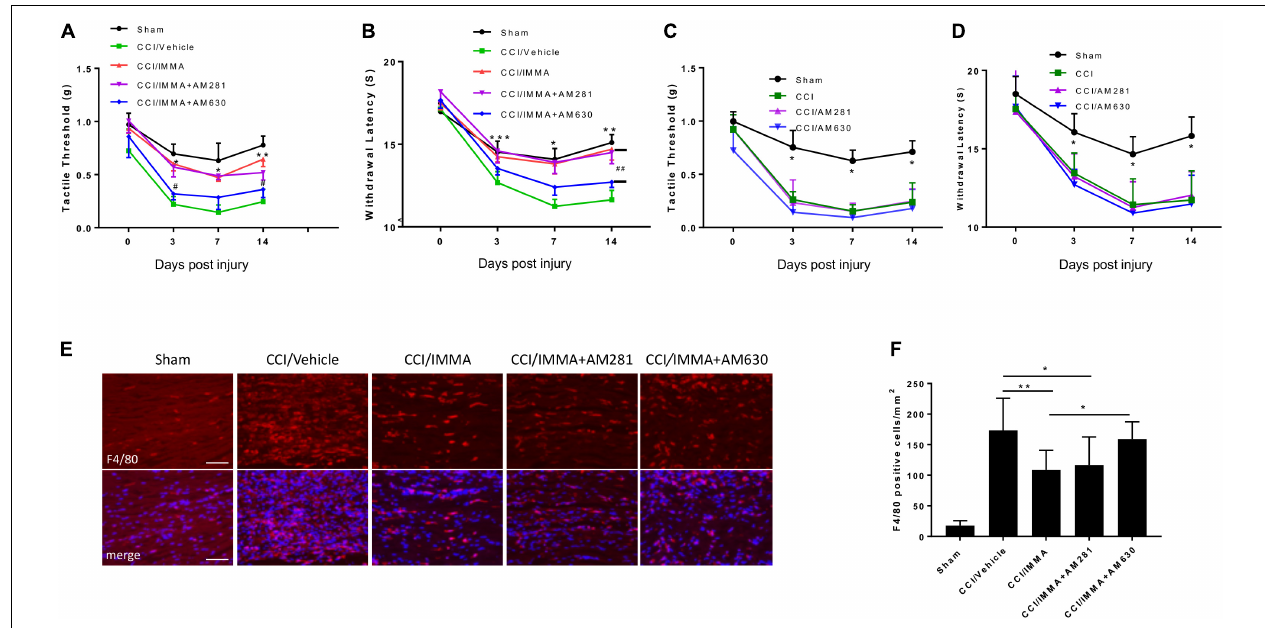
FIGURE 2 | The analgesic effects of IMMA in CCI mice were partially mediated by CB2 cannabinoid receptor. Co-administration of IMMA with the CB1 receptor antagonist AM281 in the CCI mouse resulted in similar anti-allodynic and anti-hyperalgesia effects to the IMMA alone treatment group (A,B) . Treatment with IMMA and the CB2 receptor antagonist AM630 exhibited a tendency of reduced mechanical thresholds compared to the IMMA alone group ( A ; ∗ p < 0.05, ∗∗ p < 0.01 compared between CCI/vehicle and CCI/IMMA; # p < 0.05 between CCI/IMMA and CCI/IMMA plus AM630, n = 10/group). The thermal withdrawal latency was significantly reduced in IMMA and AM630 treatment group compared to the IMMA alone group ( B ; ∗ p < 0.05; ∗∗ p < 0.01; and ∗∗∗ p < 0.001 were obtained when the CCI/vehicle group was compared to the IMMA treatment groups; ## p < 0.01 compared between IMMA group and IMMA plus AM630 treatment group, n = 10/group). Cannabinoid receptor antagonists alone had no effect on neuropathic pain. The CCI mice treated with AM281 or AM630 exhibited similar tactile threshold (C) and thermal withdrawal latency (D) to the CCI group. ∗ p < 0.05 was obtained when the CCI/vehicle, AM281 and AM630 treated groups were compared to the sham group ( n = 7/group). Macrophage infiltration to the injured sciatic nerve at 14 days post-CCI was also significantly reduced by IMMA treatment, and this effect was reversed by addition of AM630, but not AM281 ( E,F ; ∗ p < 0.05; ∗∗ p < 0.01; and ∗∗∗ p < 0.001. n = 6/group). Data obtained for neuropathic pain behaviors (A–D) were analyzed using two-way ANOVA, and one-way ANOVA was used for quantifying the differences in F4/80 staining among the various groups (F) . The Tukey-Kramer post hoc test was used for all the comparison. The merged images in E showed the co-localization of F4/80 (red) and DAPI (blue for nuclei staining). Scale bar = 250 µ